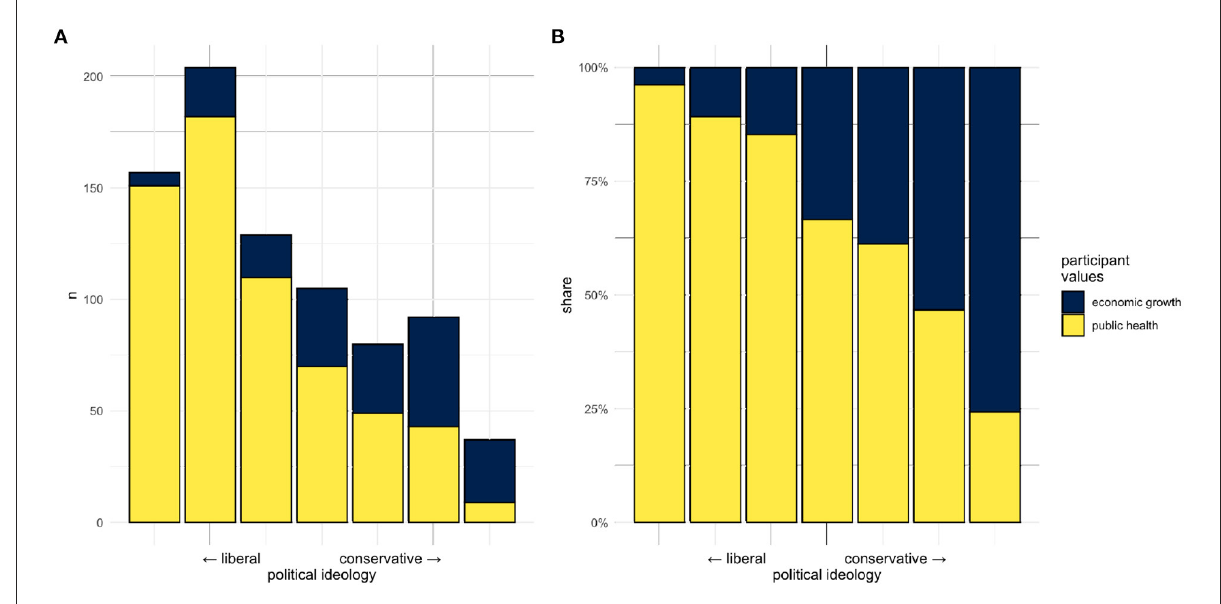
FIGURE2 Participant values by political ideology. (A) Absolute counts, (B) shares within political ideology categories. (A) Shows that our sample substantially over-represents political